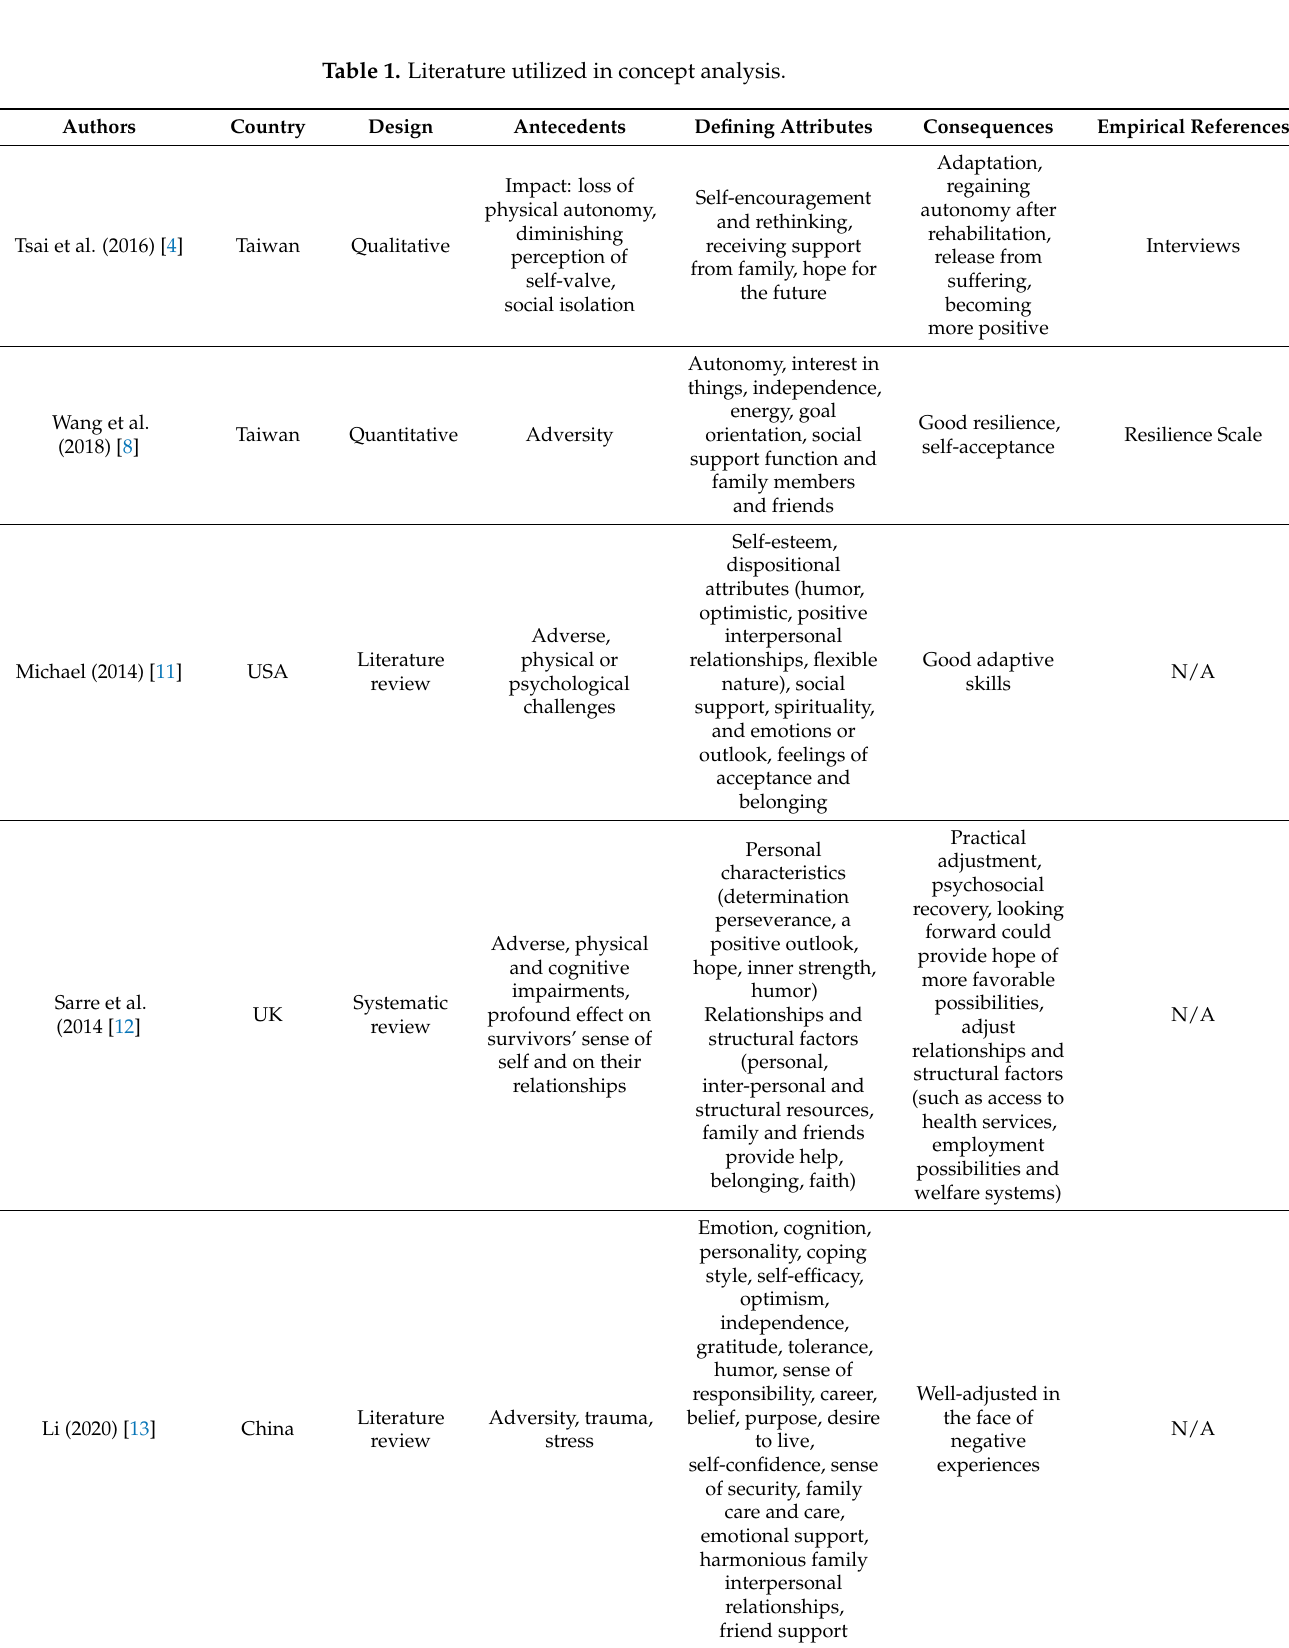
Table 1. Literature utilized in concept